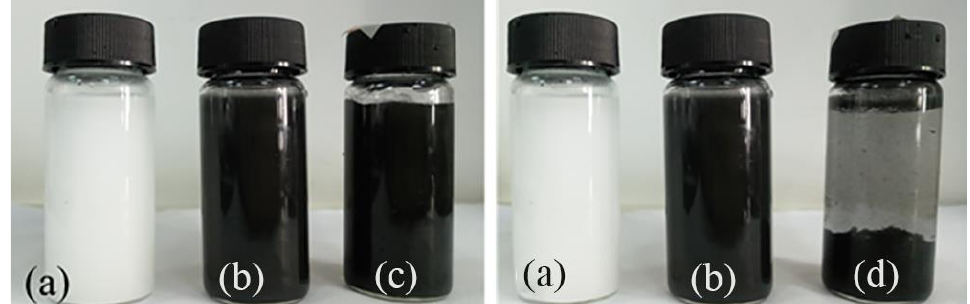
Figure 2. Photos of PDDA@BN/water dispersion ( a ), MG/water dispersion ( b ), the mixture dis- persion of PDDA@BN and MG just after mixing ( c ) and after 30 min ( d ) as a result of electrostatic self −